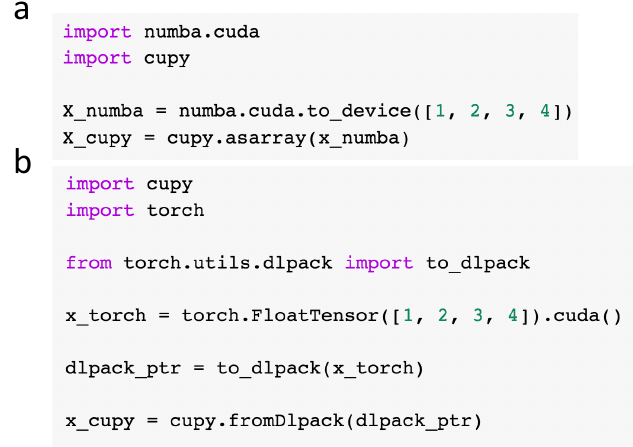
Figure 5. Examples of zero-copy interoperability between different GPU-accelerated Python libraries. Both DLPack and the __cuda_array _interface__ allow zero-copy conversion back and forth between all supported libraries. ( a ) creating a device array with Numba and using the __cuda_array_interface__ to create a CuPy array that references the same pointer to the underlying device memory. This enables the two libraries to use and manipulate the same memory without copying it; ( b ) creating a PyTorch tensor and using DLPack to create a CuPy array that references the same pointer to the underlying device memory, without copying